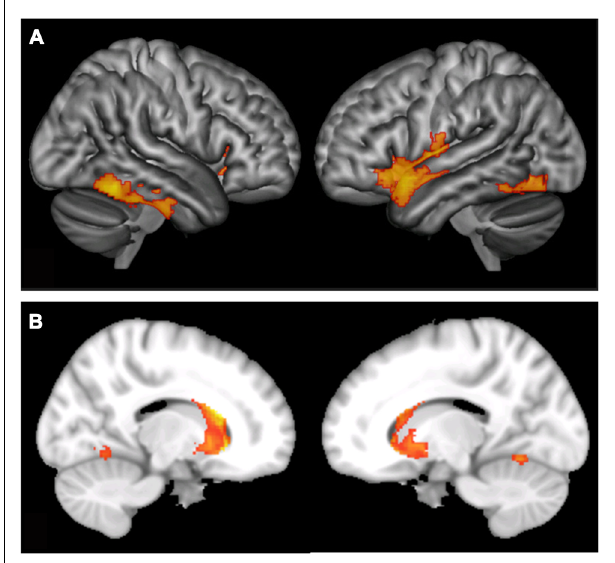
FIGURE 2 |The main effect of playing a musical instrument on gray matter volume; (A) effects in temporal cortex, occipito-temporal area, and the insula; (B) effects in caudate nucleus shown in sagittal section from both left and right hemispheres.